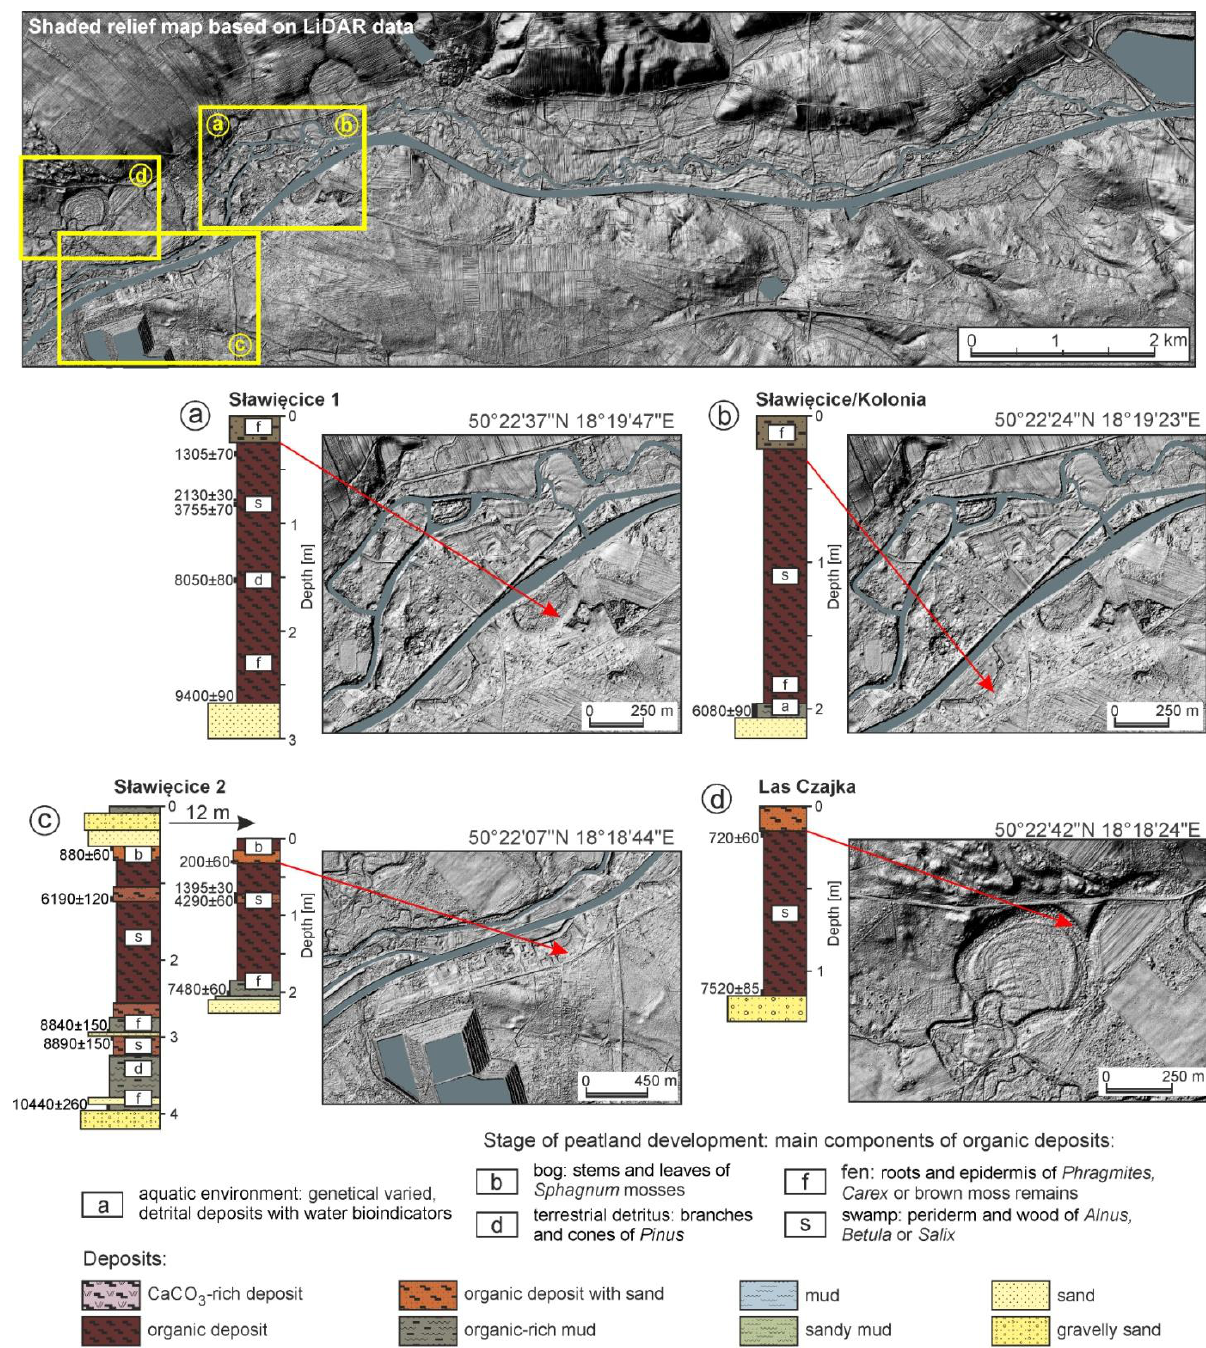
Fig. 4. Radiocarbon-dated sequences of the active wetland deposits (shaded relief map based on LiDAR data from